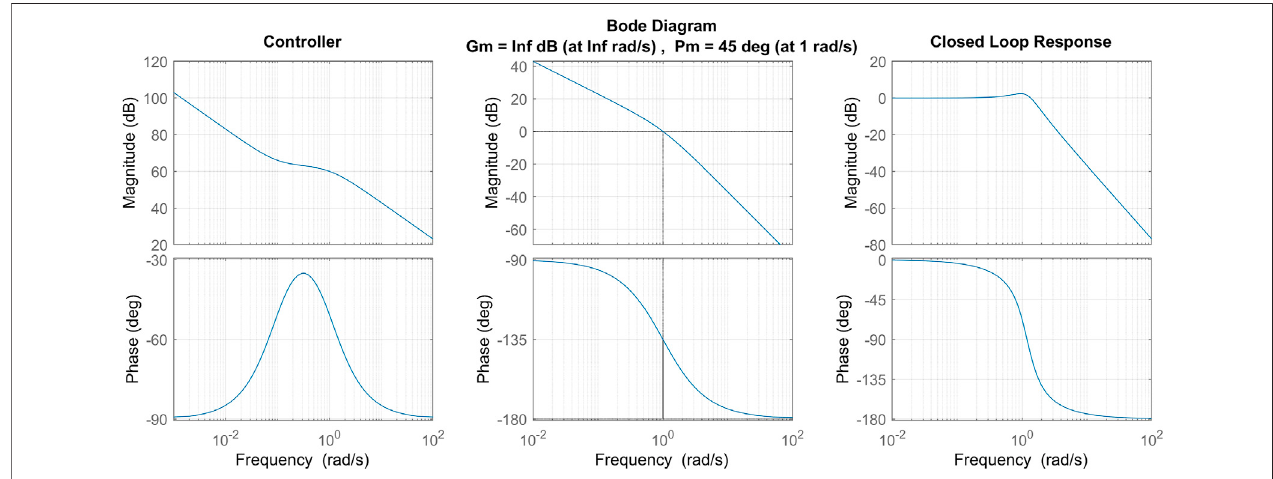
FIGURE5| Nominalcontrollerisshown (left) accordingtothecontrolschemede fi nedinthetextwith ω BW (cid:2) 1and ω z (cid:2) 0.1.Theresultingloopgain (centre) isshownbased on nominal controller and plant models with M (cid:2) 1000 and B (cid:2) 100. The closed loop transfer function from commanded rate to actual rate is also shown (right) .